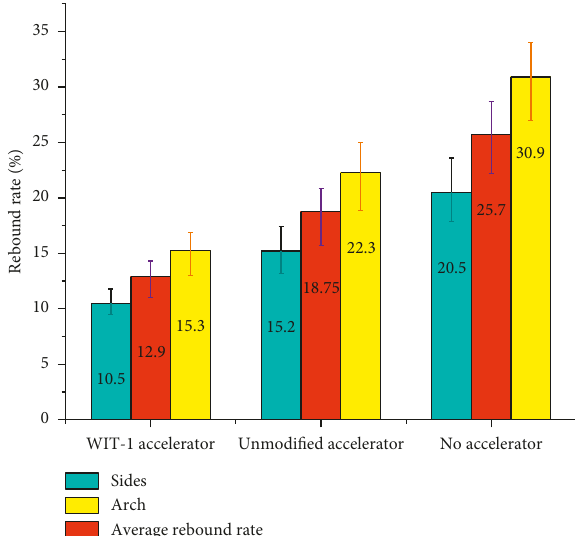
Figure 8: The comparison of three types of shotcrete rebound